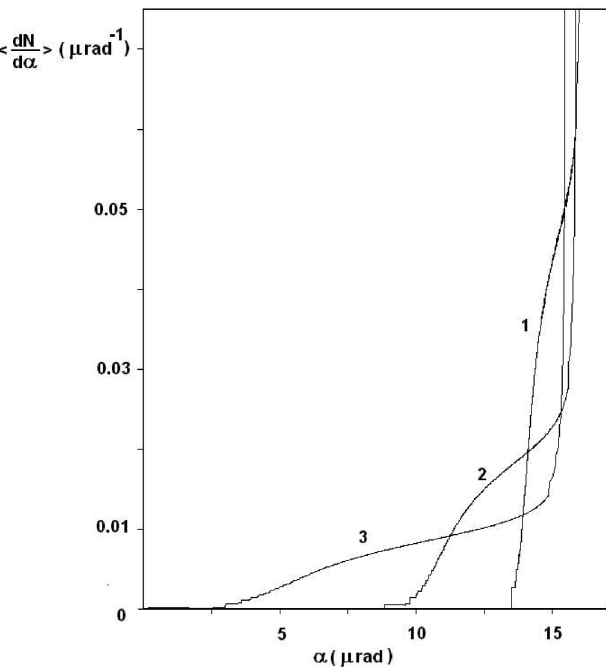
FIG. 8. Distributions of particles after volume reflection and multiple scattering (at the output of a single crystal) as functions of the deflection angle. The zero angle corresponds to the initial direction of a beam. Calculation was made for different radii: 25 m (a), 10 m (b), and 5 m (c). For additional information, see